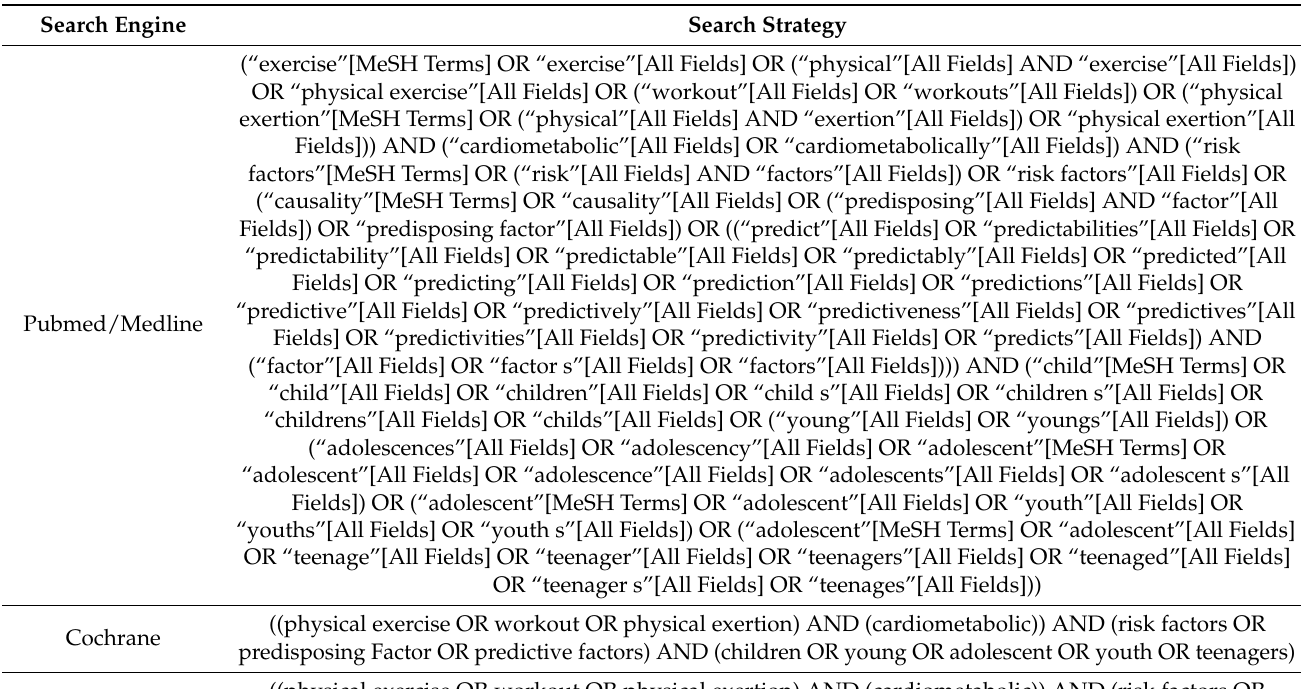
Table 1. Detailed search